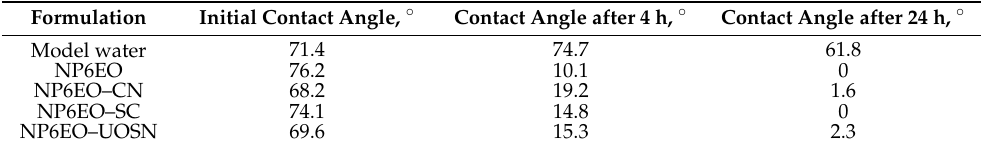
Figure 5. Changes in contact angle after 4 and 24 h aging of core in surfactant solutions. Table 3. Results of contact angle study. Table 3. Results of contact angle